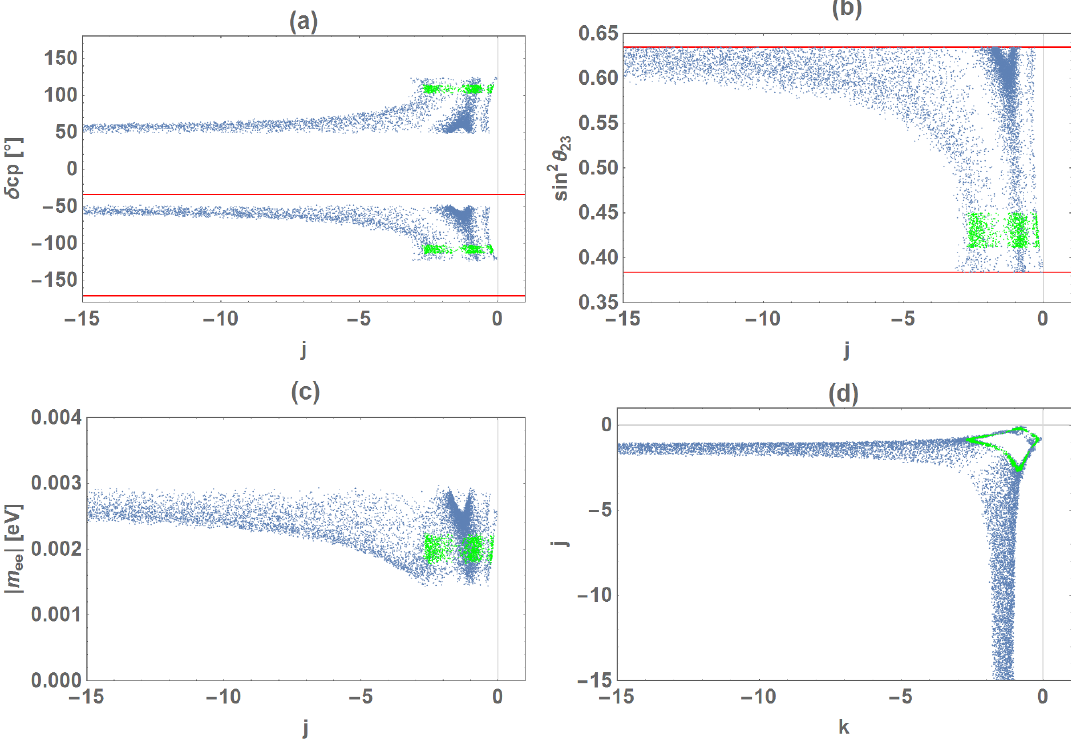
Figure 5 . Blue (green) dots denote predictions for arbitrary j in TM 1 (NH) within 3 (cid:27) (1 (cid:27) ). The red lines for sin 2 (cid:18) 23 and (cid:14) CP denote the experimental bounds of 3 (cid:27) (global analyses) and 2 (cid:27) (T2K) ranges, respectively: (a) (cid:14) CP versus j , (b) sin 2 (cid:18) 23 versus j , (c) j m ee j versus j , and (d) k versus j